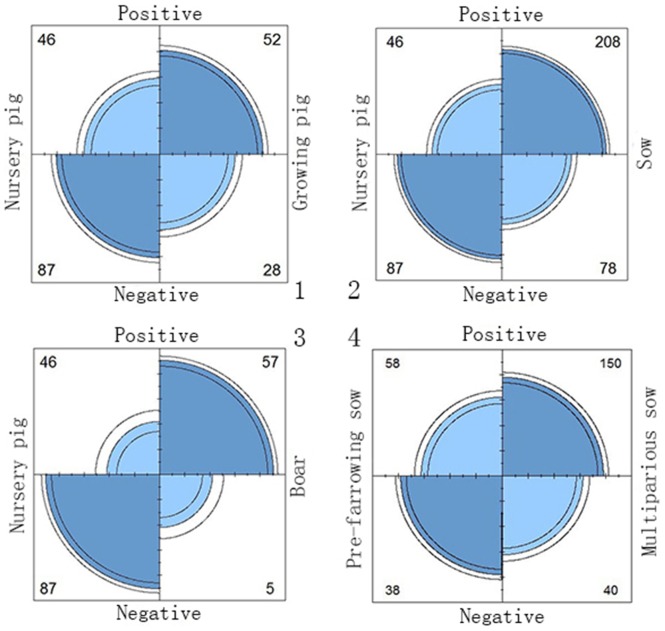
Fourfold plot for odds ratio (OR).Univariate analysis results are presented in the Fourfold plot diagram. Fourfold display for seropositive data of sows: Evidence for pig herds bias or multiparity bias? The area of eachshaded quadrant shows the frequency, standardized to equate the margins for different herds and seropositive. Circular arcs show the limits of a 95% confidence interval for the odds ratio. 1. Compared with nursery pigs, the OR of growing pigs was 3.51(95%CI, 1.95–6.33; p<0.0001); 2. Compared with nursery pigs, the OR of sows was 5.04(95%CI, 3.27–7.77; p<0.0001); 3. Compared with nursery pigs, the OR of boars was 21.56(95%CI, 9.47–49.10; p<0.0001); 4. Compared with pre-farrowing sows, the OR of multiparous sows was 2.46(95%CI, 1.45–4.18; p<0.01).